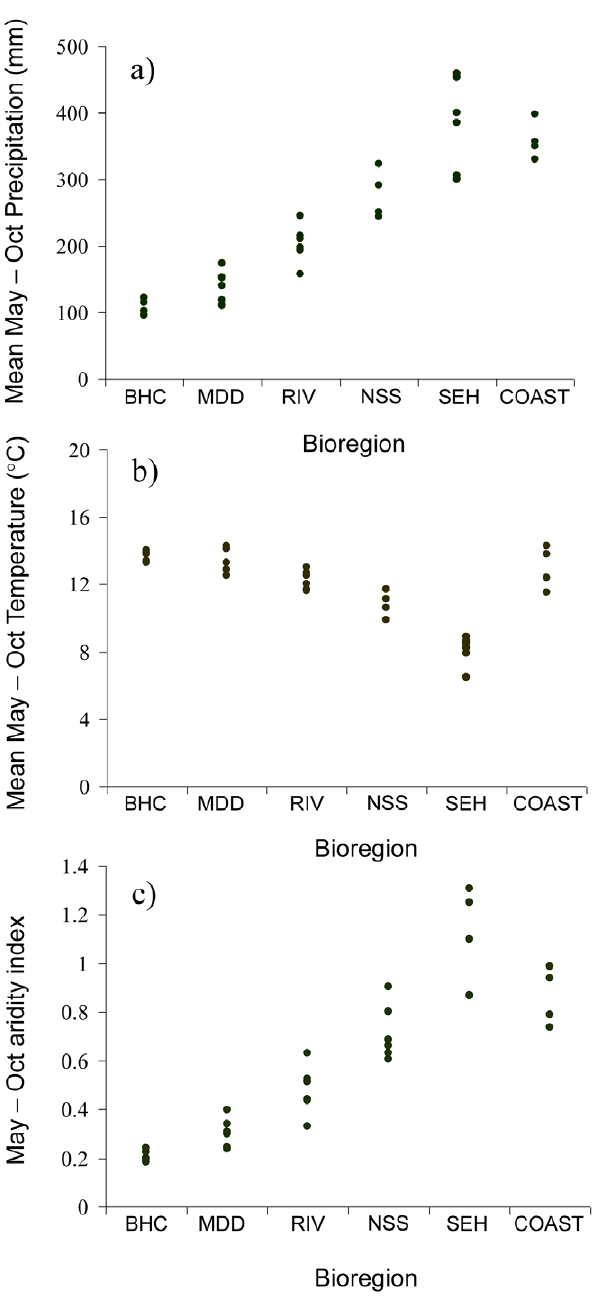
Figure 2. Climatological data for the May–October growing season for bioregions in the study area. Data are based on 1910– 2010 averages derived from the enhanced meteorological dataset hosted by The State of Queensland (Department of Environment and Resource Management) 2012 (http://www.longpaddock.qld.gov.au/silo/ ). (a) Total precipitation (mm). (b) Mean temperature ( u C). (c) Aridity Index. Abbreviations denote the individual bioregions, See Fig. 1 for full names. Bioregions are arranged along the x axis from most westerly (BHC) to most easterly (COAST).